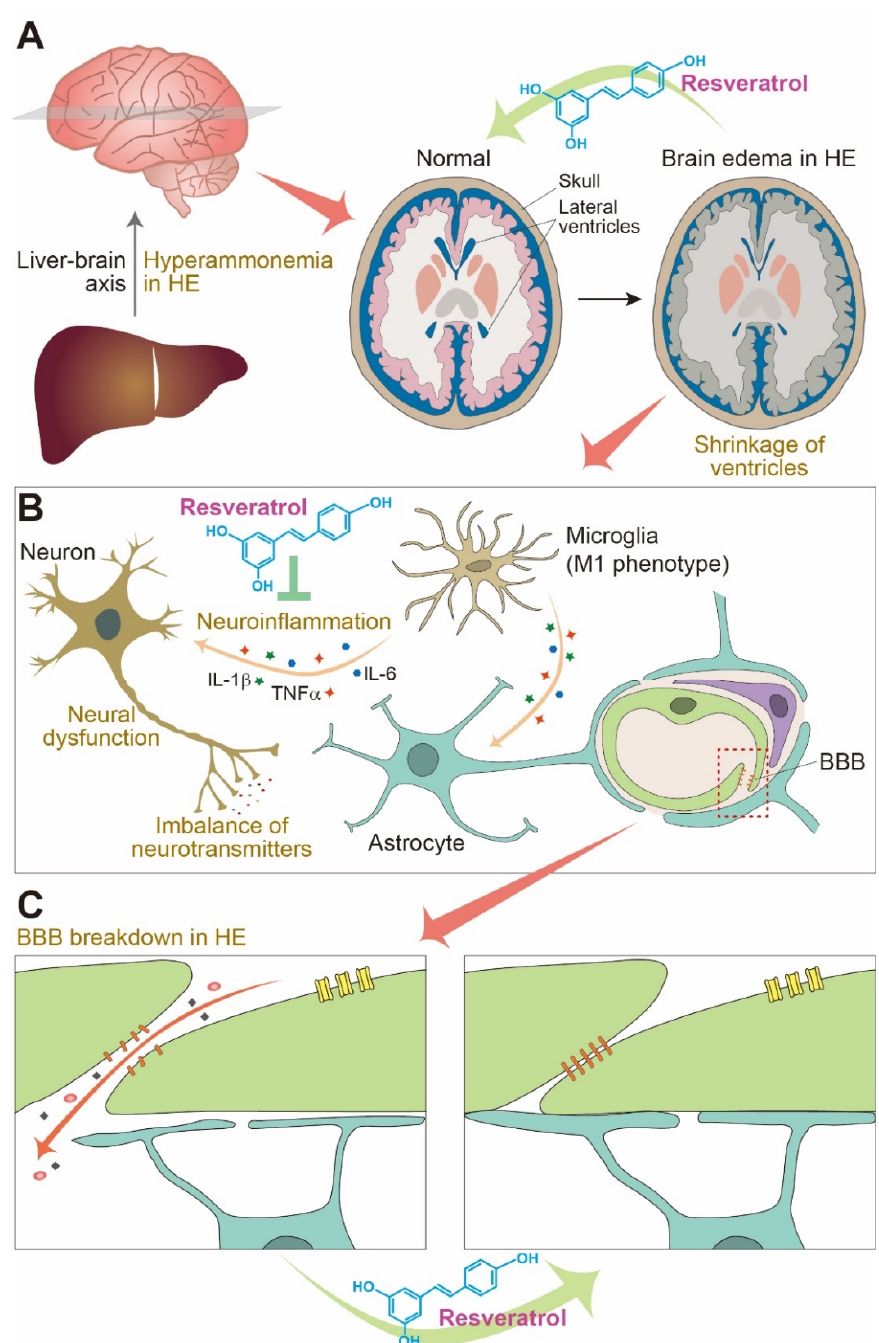
Figure 1. The pathogenic process of hepatic encephalopathy (HE) in the brain and the possible protective effects of resveratrol. ( A ) HE in the brain is linked to the development of several specific features including hyperammonemia, brain edema, neuroinflammation, and blood-brain barrier (BBB). Resveratrol may protect brain endothelial cells, astrocytes, and neurons against hyperammonemia-induced damage, and finally circumvents brain edema. ( B ) In addition, resveratrol may reduce neuroinflammation by suppressing inflammatory cytokine expression, and ( C ) protects against BBB disruption by helping to maintain a tight junction protein density within the BBB. Note that the protective effects of resveratrol shown in this figure are hypothetic effects based on the current empirical evidence and do not represent the proven effects of resveratrol on patients with HE. See text for details. IL: interleukin, TNF: tumor necrosis factor.